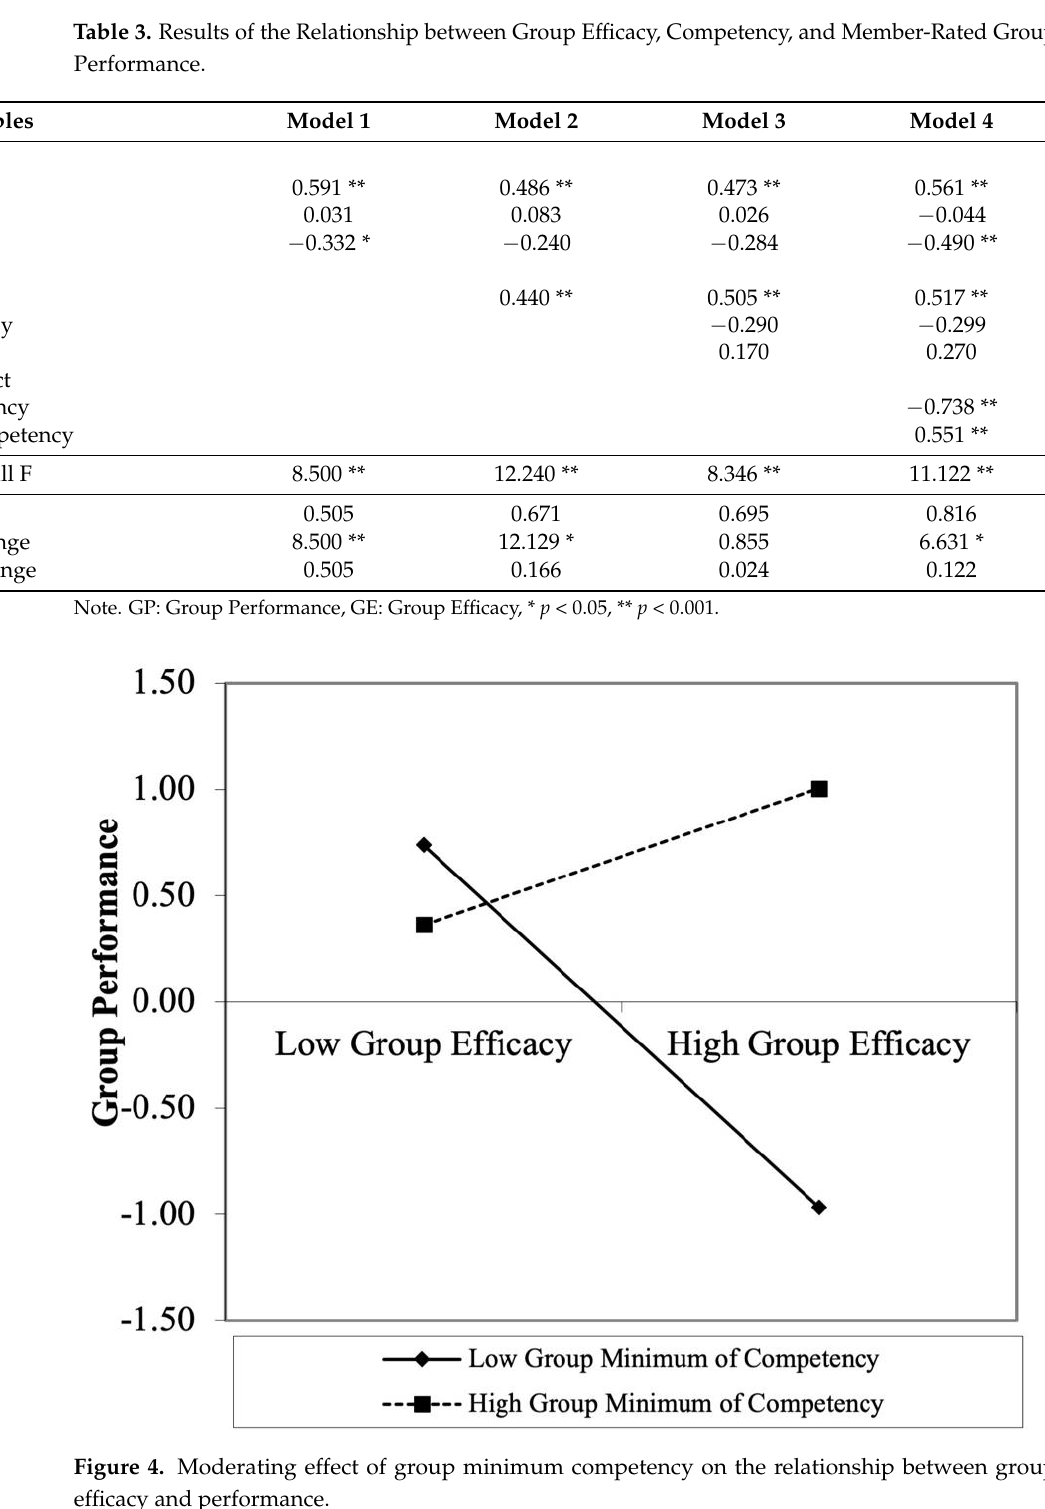
Figure 5. The region of significance of the moderating effect of group minimum competency. Note: The moderating effect is significant when the moderator is greater than −0 .38 and smaller than −2 .99. X-axis: Moderator, Y-axis: Simple slope. 5. Discussion and Conclusions We examined the moderating effects of group average and minimum competency on the relationship between group efficacy and performance. In concurrence with social cog- nitive theory [2] and prior meta-analytic findings [4,5], the positive relationship between group efficacy and group performance was verified. The more efficacious groups are, the